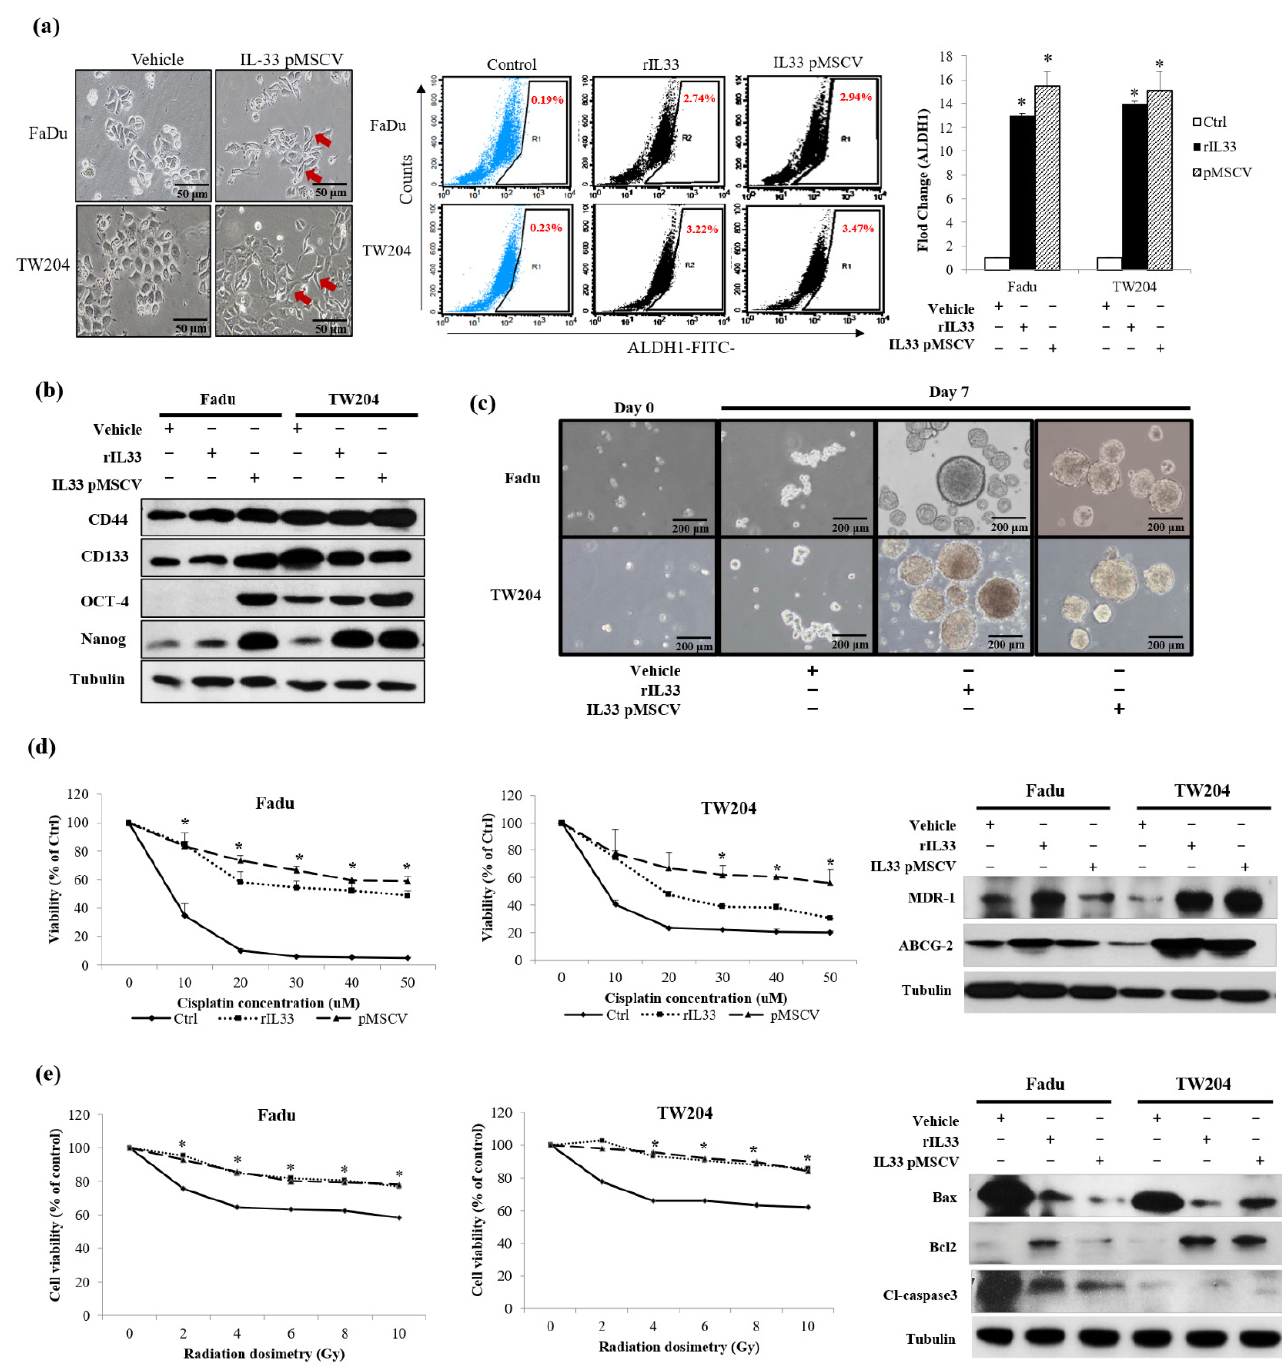
Figure 3. Characterization of the two stably cloned IL-33-overexpressing HNSCC cells facilitated by an additional IL-33 expression that led to the induction of the CSC properties. (( a ), left) A more aggressive phenotype was seen in the stable clones of the IL-33-overexpressing HNSCC cells (arrows) acting in an autocrine manner, compared with the parent cells. Using the recombinant IL-33 for the paracrine effect of the CAF-induced IL-33, showed a similar effect. There were significant differences in both the stably cloned HNSCC cells and HNSCC cells exposed to the recombinant IL-33 compared with the control HNSCC cells ( p < 0.05). (( a ), middle and right) Flow cytometric analysis of ALDH1 showed significantly increased activity in both the stably cloned HNSCC cells and HNSCC cells exposed to the recombinant IL-33 compared with the control HNSCC cells ( p < 0.05). ( b ) Western blotting analysis showed the overexpression of CSC-representative